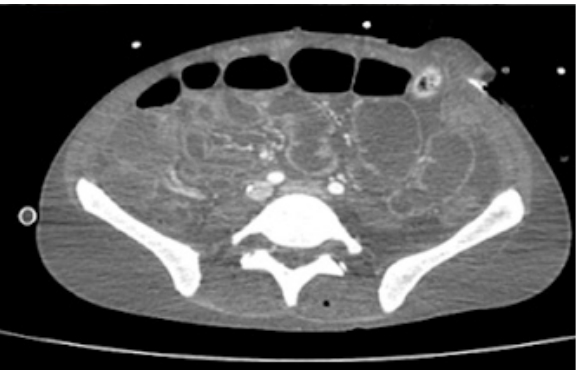
Table 1. Timeline of main events regarding ART modification of initiation and HIV restaging.